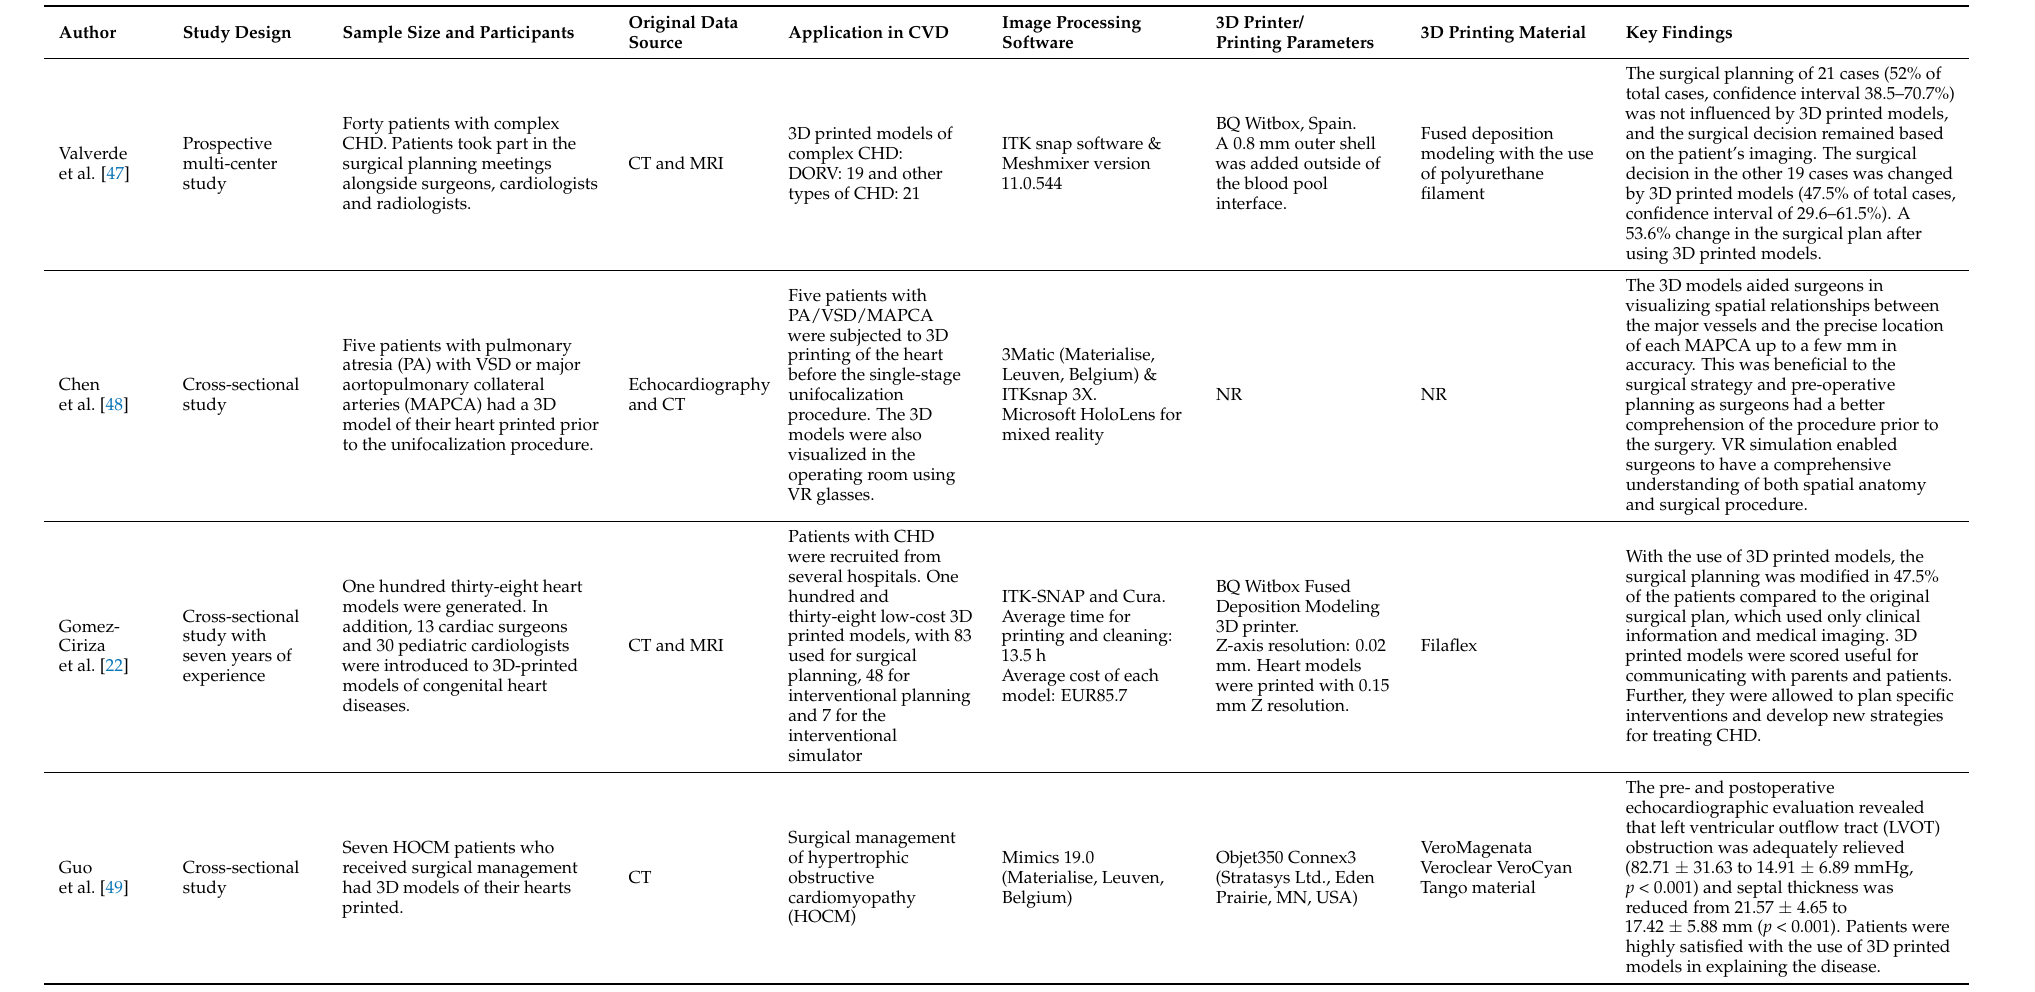
Table 3. Clinical value of 3D printed models in surgical planning of cardiac